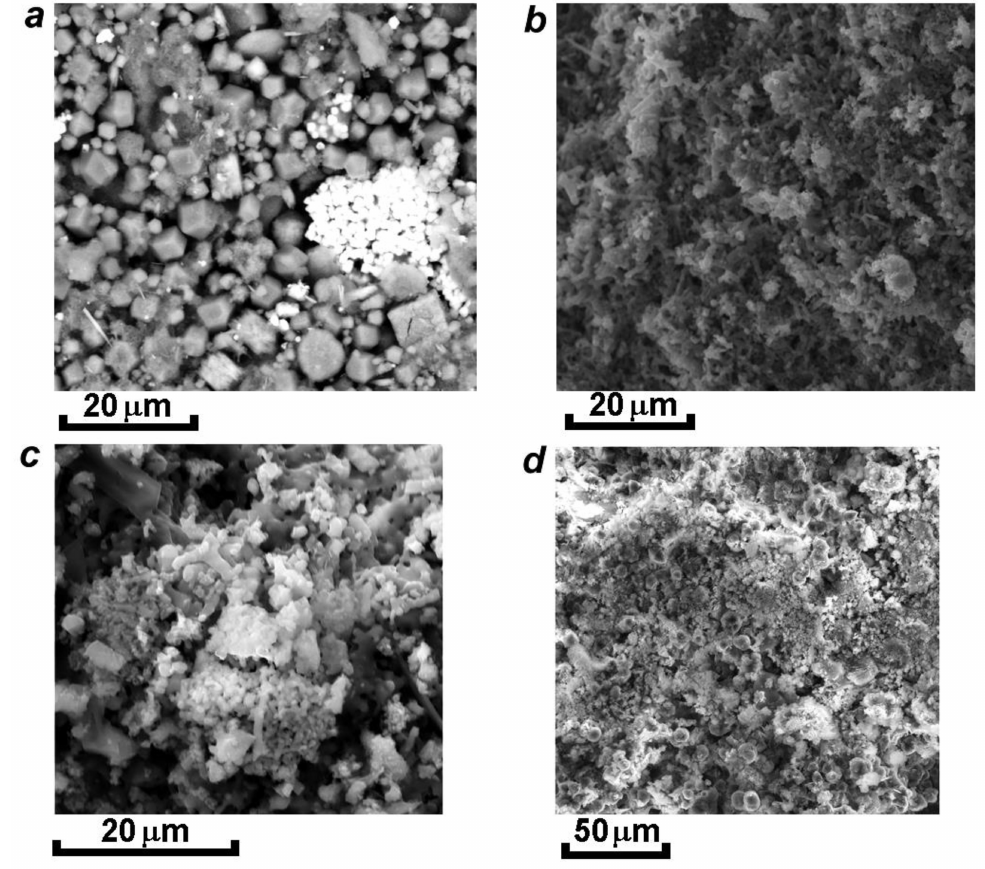
Figure 26. Aggregates of ( a ) synthetic analogue of sapozhnikovite obtained in Experiment 1, ( b ) intimate intergrowth of sodalite- and cancrinite-type phases mixture from Experiment 2, ( c ) product of Experiment 2a and ( d ) cancrinite-type phase from the Experiment 6. SEM photos obtained in the BSE ( a ) and SE ( b – d ) modes.